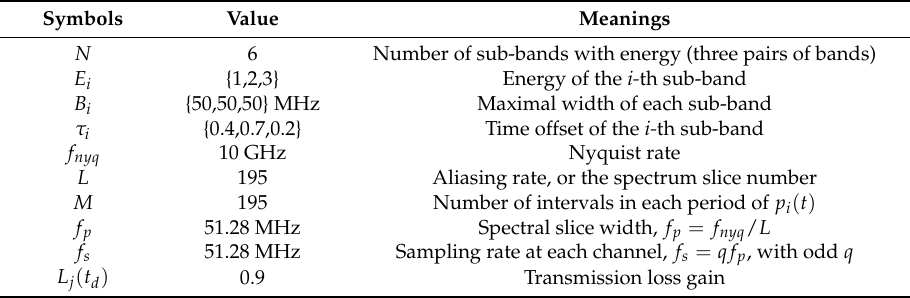
Table 3. Simulation